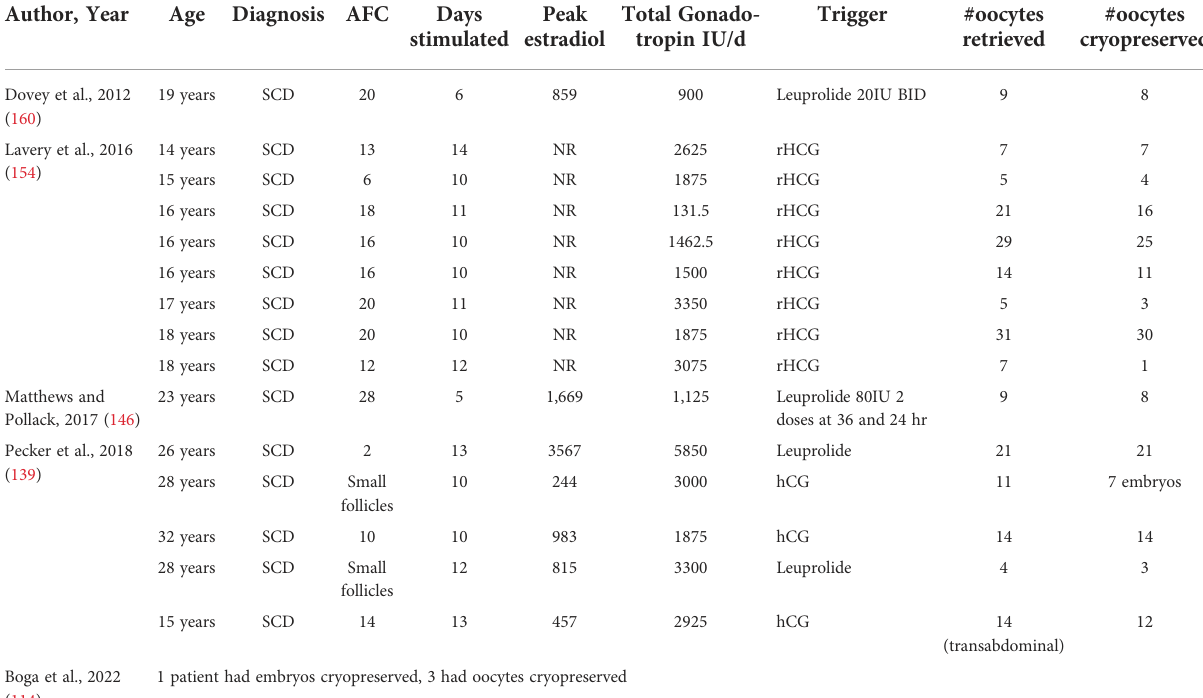
TABLE 4 Cases of controlled ovarian hyperstimulation in patients with hemoglobinopathies. Author,